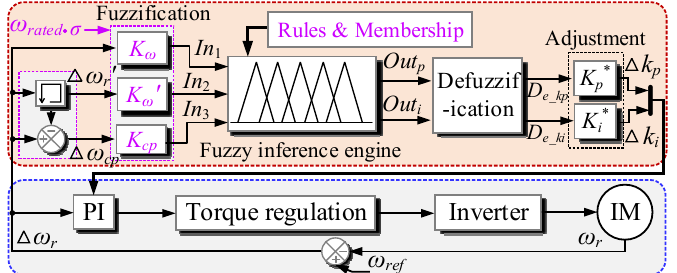
Figure 2. Block diagram of improved fuzzy adaptive speed PI controller used for IM control.